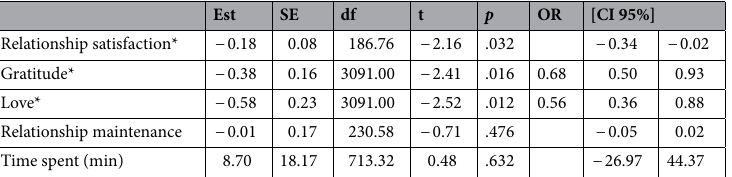
Table 2. Associations between rs6449182 and baseline daily relationship measures. * p < .05; Est. represents an unstandardized regression coefficient from a multi-level model regressing the dependent measure from the 14-night baseline phase on genotype.